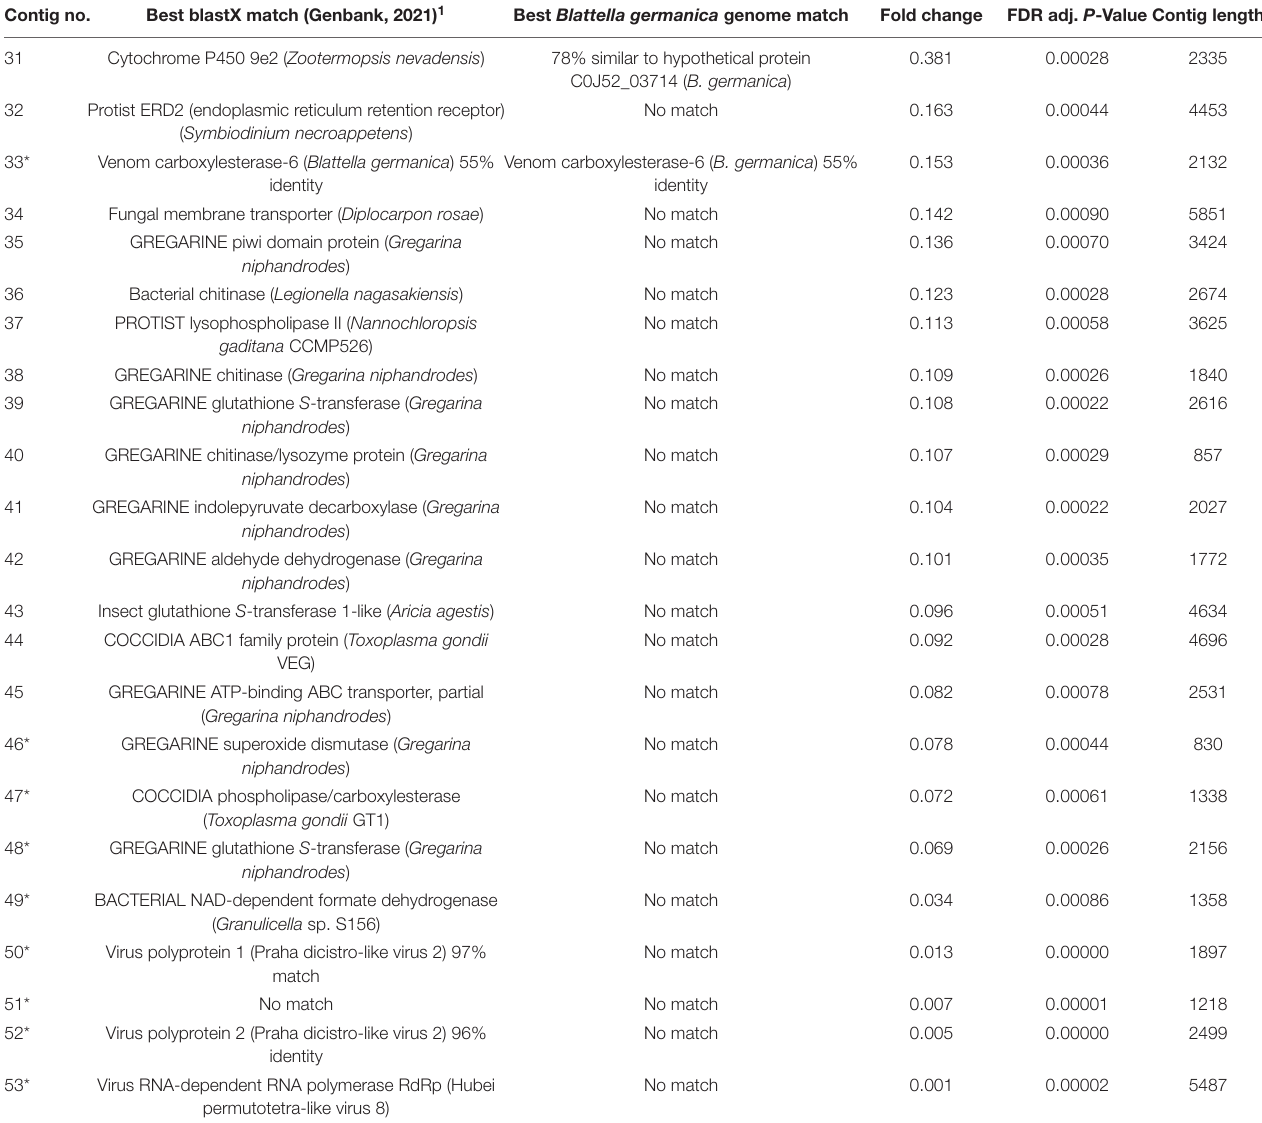
Virus RNA-dependent RNA polymerase RdRp (Hubei permutotetra-like virus 8) The order shown is ranked from most highly upregulated (top) to most downregulated (bottom). All 53 contigs were tested in qRT-PCR validations against Illumina read count data, and a subset of 21 contigs indicated by asterisks ∗ was used for post hoc regression comparisons between different strains (see Figure 6 ). Values shown are based on voom-limma analysis. See Supplementary Table 2 for primer sequences. 1 nr database at